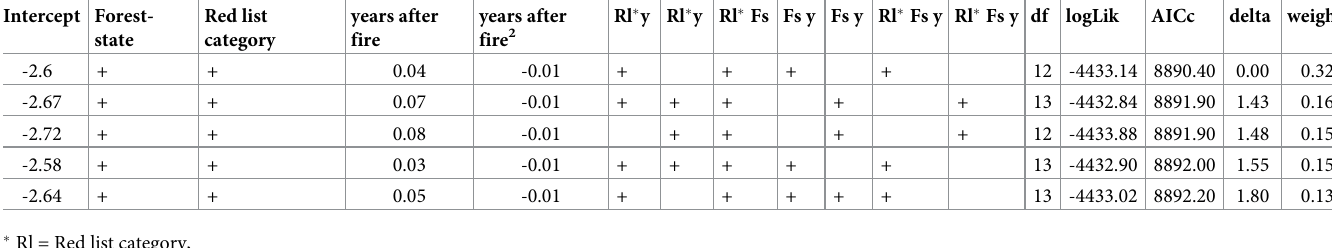
Table 3. Model selection table for Red list analysis with territories.